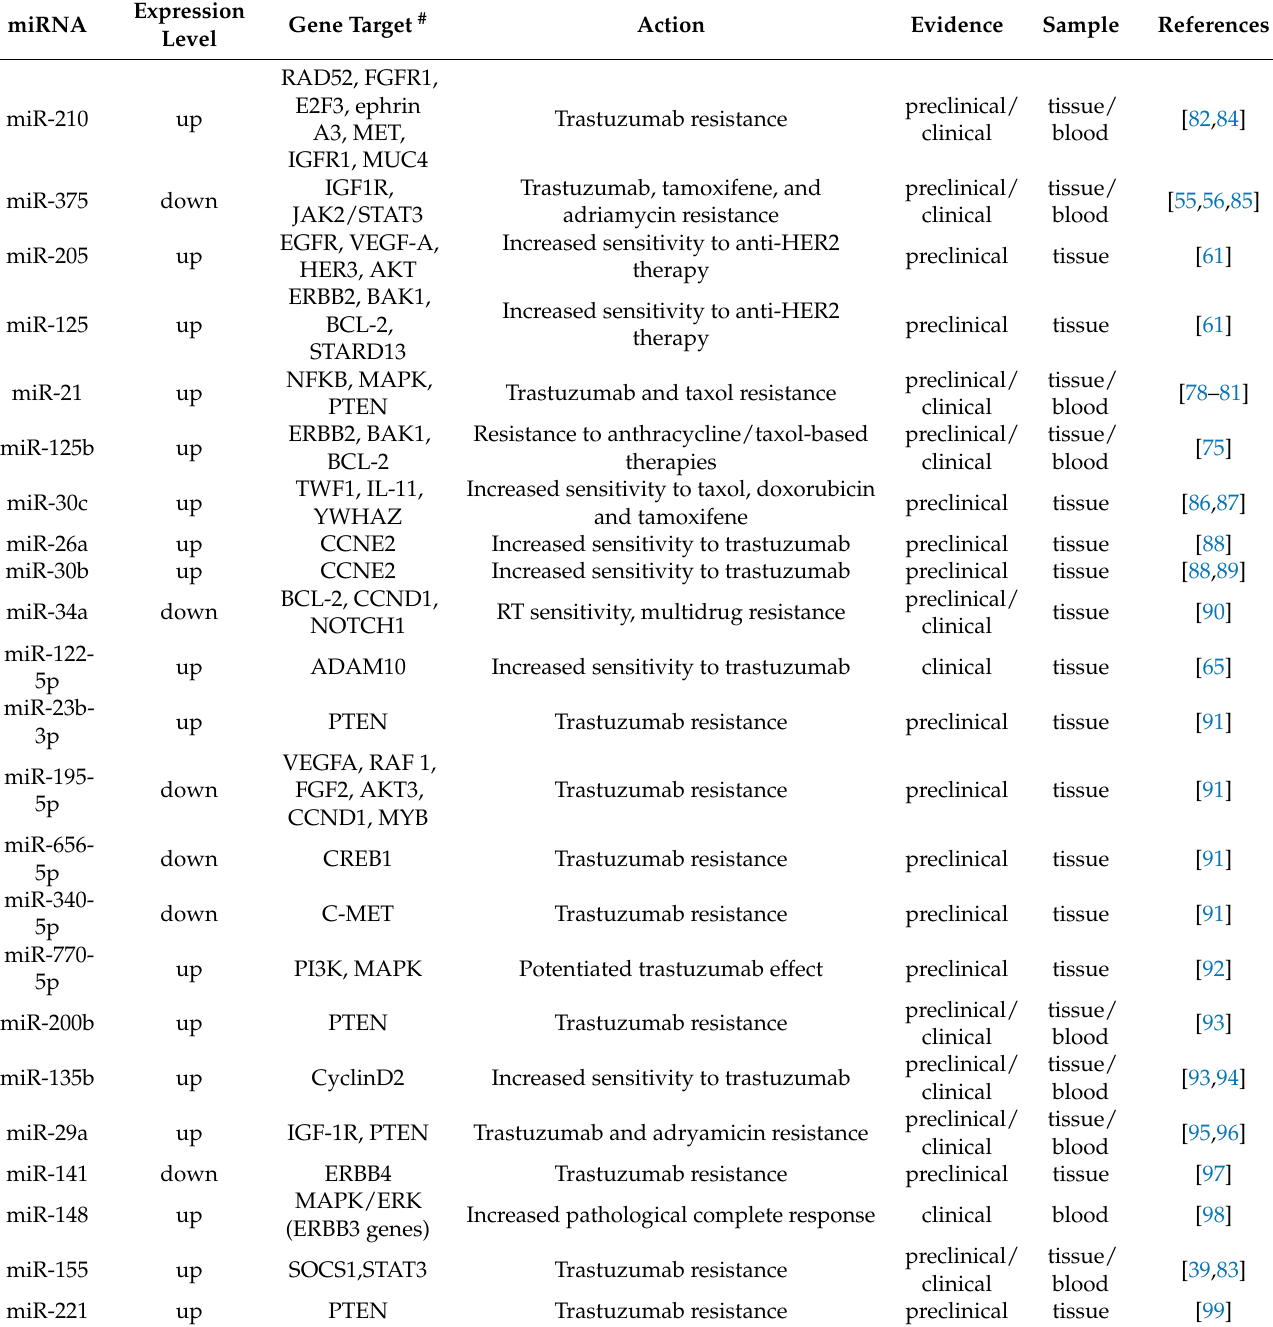
Table 2. Predictive value for treatment outcomes of miRNAs expressed in HER2-positive early breast cancer.